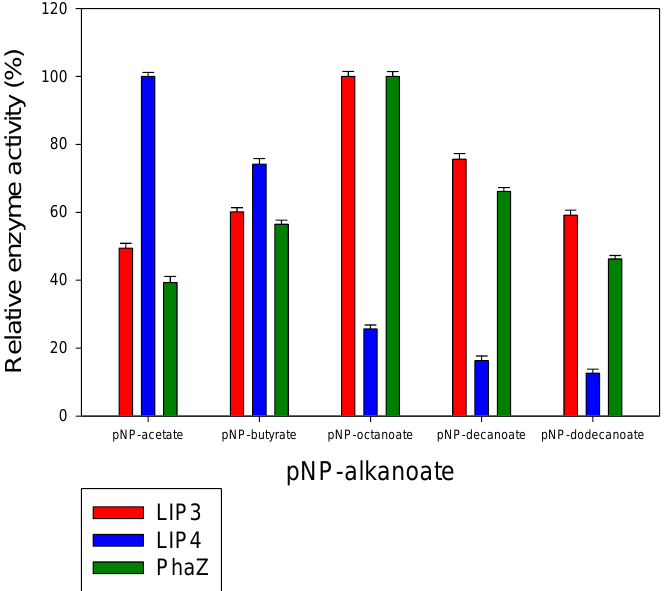
Figure 7. Determination of the activities of LIP3, LIP4, and PhaZ towards different substrates. Substrate specificity of lipases LIP3 (red bars), LIP4 (blue bars), and PhaZ (green bars) from P. chlororaphis PA23. The reaction mixture contained 1 mmol L −1 of various p-nitrophenyl (pNP) alkanoates and 0.025 mg of purified enzyme under optimal conditions of the enzymes. The maximum activity observed was taken as 100%. The 100% activity for LIP3, LIP4, and PhaZ corresponded to Table 3. Substrate specificity of purified LIP3, LIP4, and PhaZ.